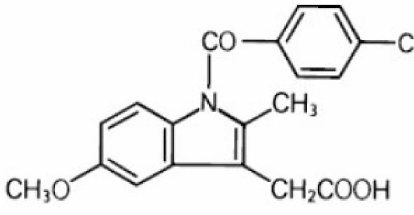
Figure 2. Structure of indomethacin.